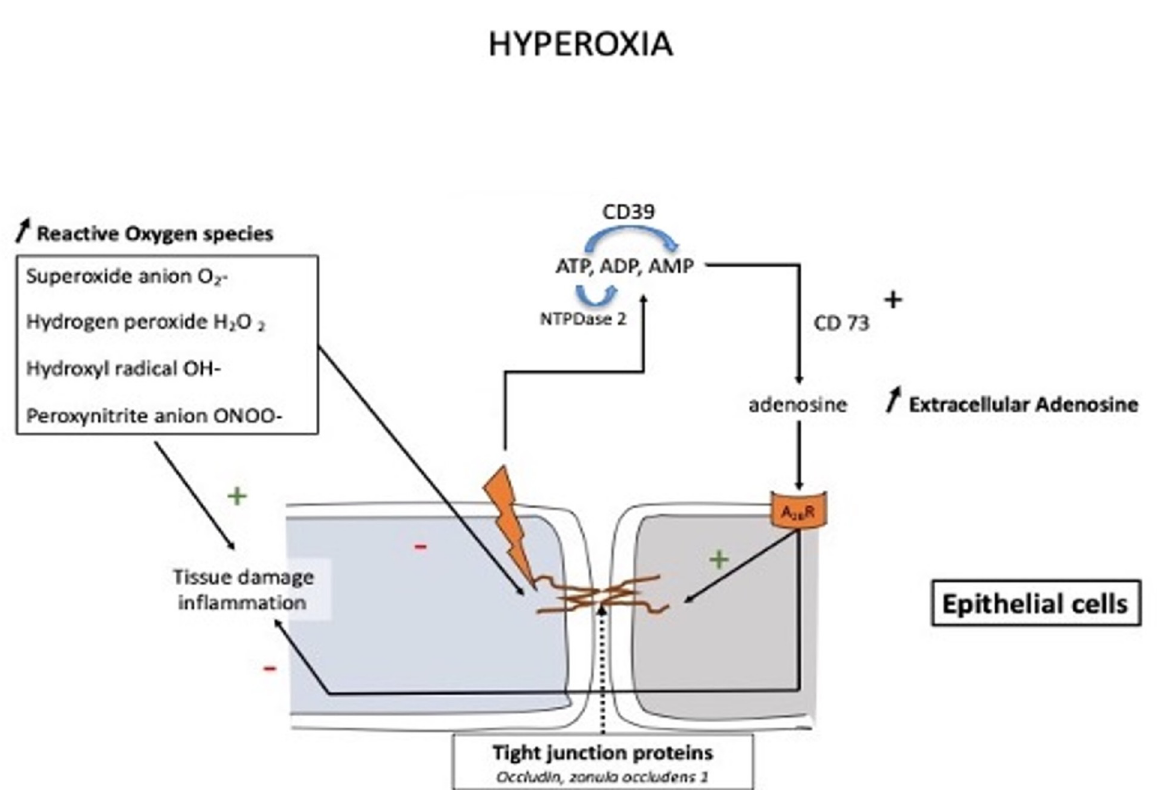
Figure 2. Schematic presentation of the protective action of the adenosine system in pulmonary oxygen toxicity. Prolonged exposure to high oxygen partial pressure leads to an impairment in pulmonary barrier function through inflammation and disruption of the tight junction via a downreg- ulation of tight junction proteins such as occludin, zonula occludens-1, and claudin-4. The increase in adenosine is mainly due to the activation of CD73, which converts AMP into adenosine, while other nucleotidases such as CD39 (NTDPase1) or NTDPase2 may also participate in the modulation of extracellular adenosine levels.